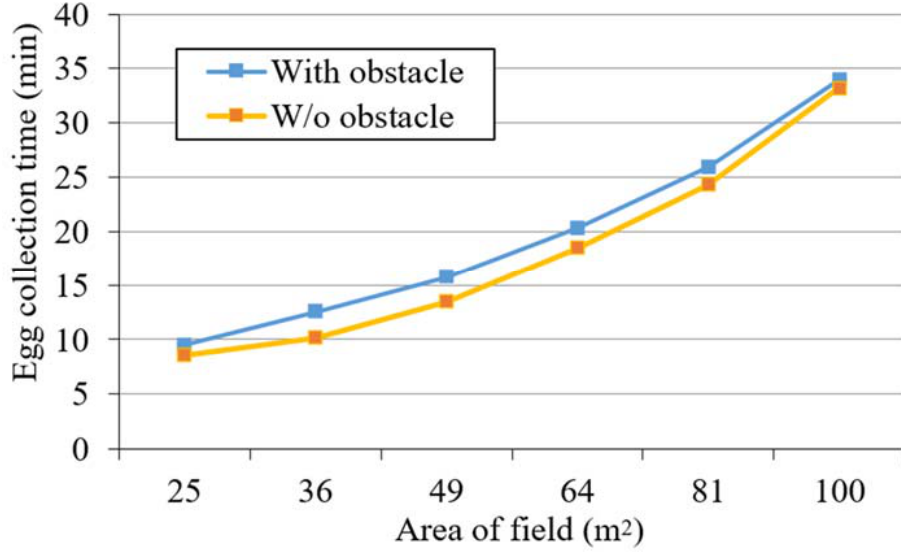
Figure 17. Size of the field versus egg collection time.